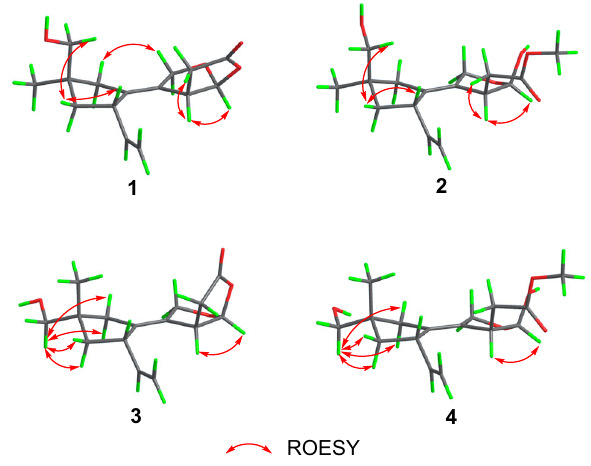
Fig. 3 Key ROESY correlations of compounds 1 –